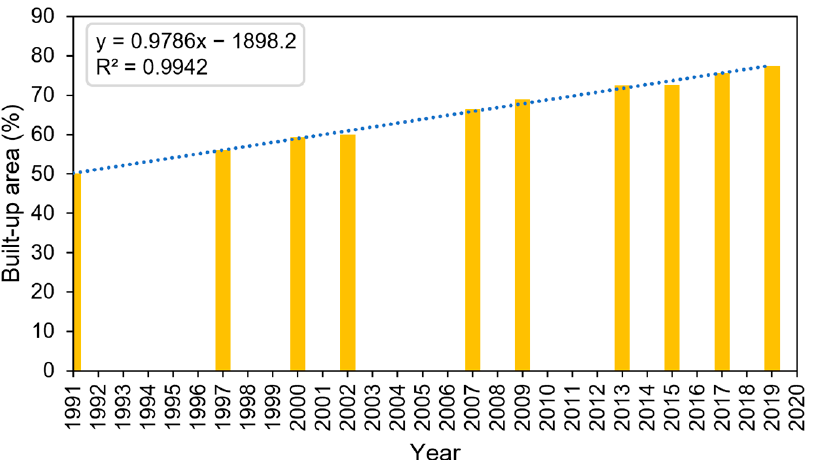
Figure 5. Percentage of built-up areas classified from Landsat images with a linear fit line showing a positive trend.